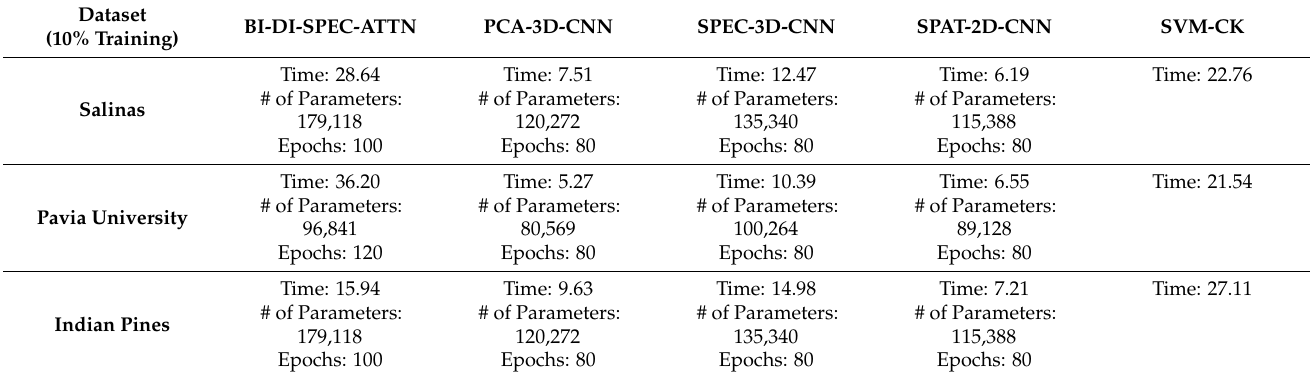
Table 7. Overall execution time (in minutes) of all the models in comparison for 10% training data.